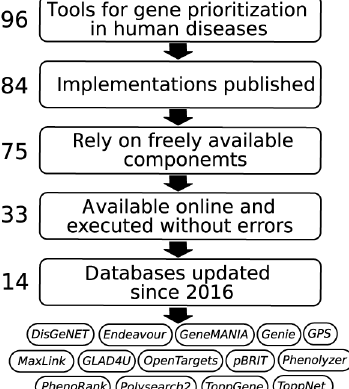
Figure 3: The process of gene prioritization tools selection for further detailed